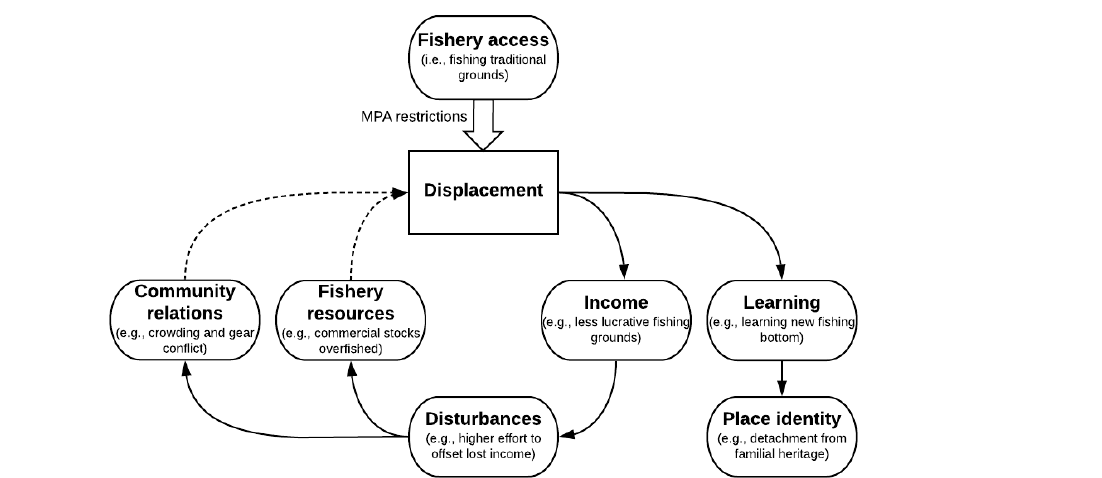
Fig. 4 . Consequences of marine protected area (MPA) displacement on attributes of social-ecological well-being. Solid arrows represent scenarios described by participants, and dashed arrows represent inferred relationships between